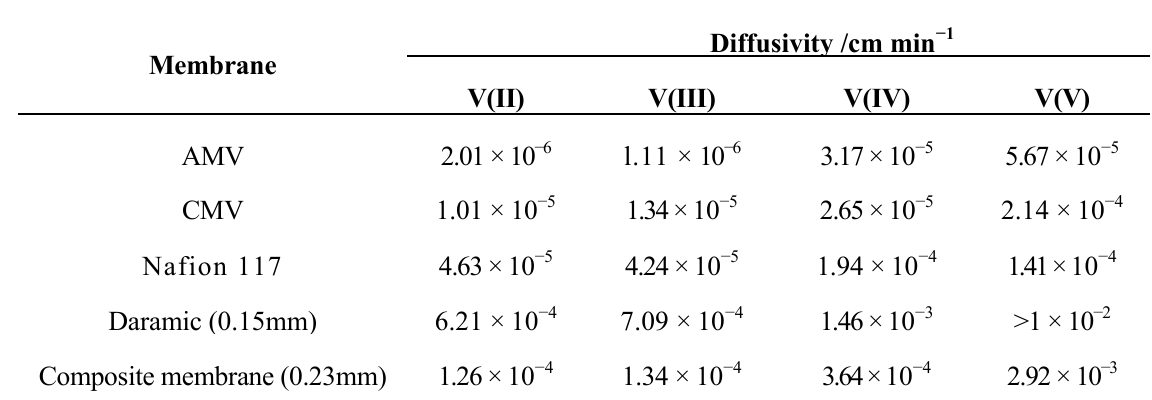
Table 1. Diffusivity (cm·min − 1 ) of vanadium ions across different membranes